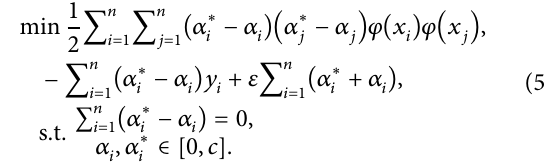
Figure 2: Flowchart of hyper-parameter optimization algorithm.